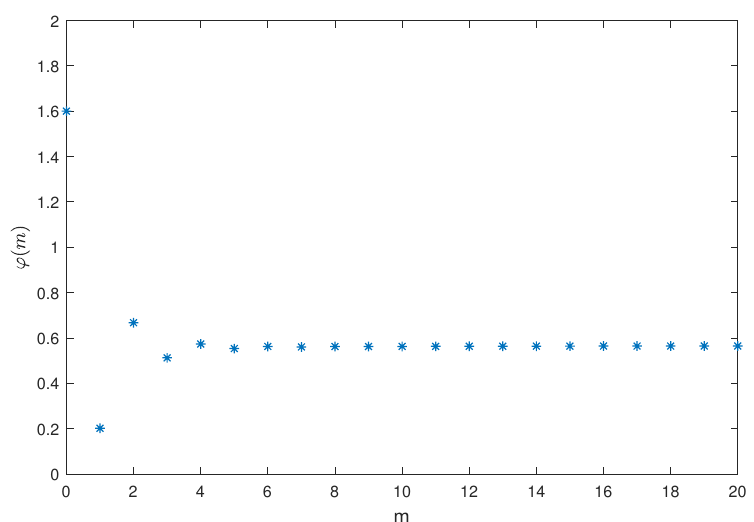
Figure 1. ϕ ( m ) of system (32) for m ∈ [ 0,20 ]